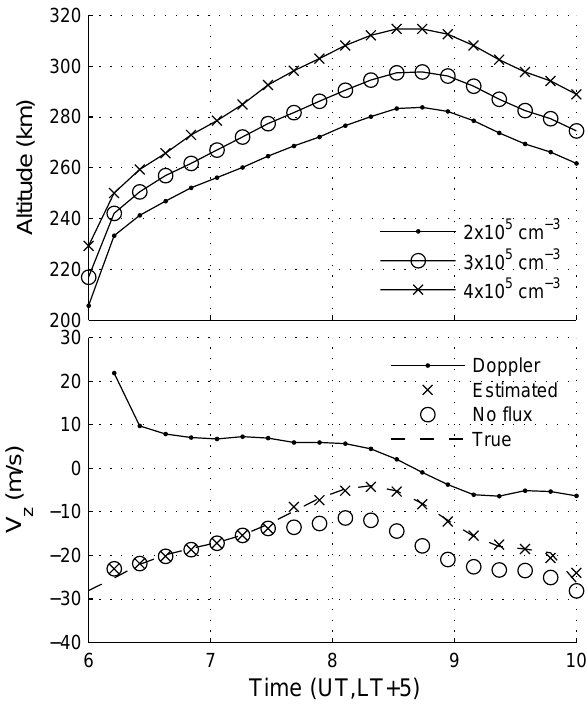
Fig. 14. The top plot shows three constant density contours using the model results presented in Fig. 11. The bottom plot shows the expected digisonde Doppler velocity (solid line with solid points), estimated velocity from density profiles (crosses), estimated veloc- ity ignoring plasma flux (circles), and true velocity (dashed